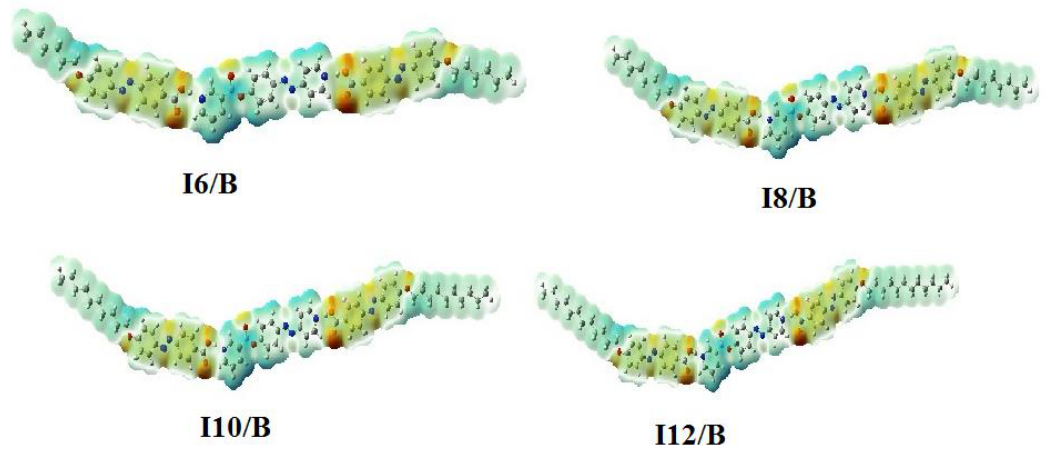
Figure 10. Molecular electrostatic potential (MEP) of I6/B, I8/B, I10/B and I12/B .